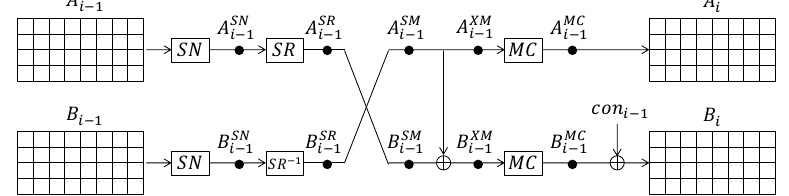
Figure 7: Illustration of the round function of